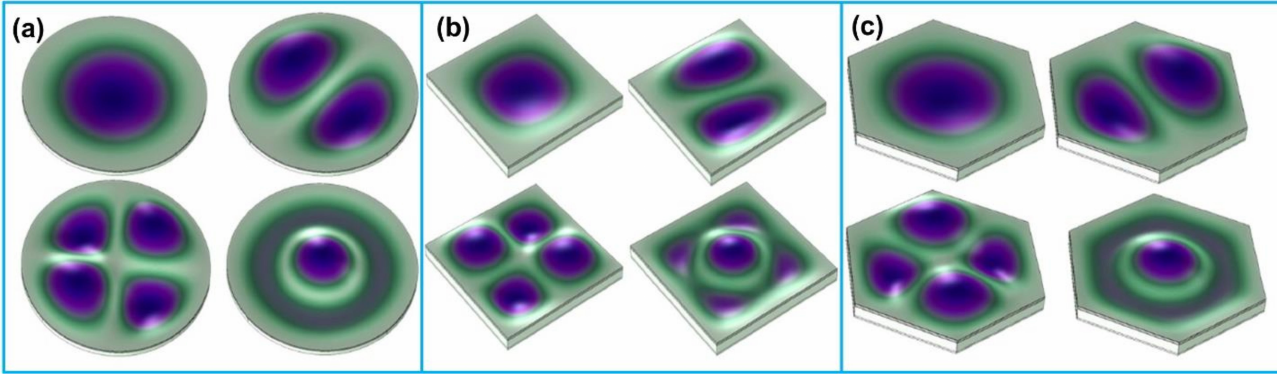
Figure 2. Vibration modes of different diaphragm structures: ( a ) circular diaphragm; ( b ) square diaphragm; ( c ) hexagonal diaphragm. ( a – c ) Reprinted from Ref. [37] with